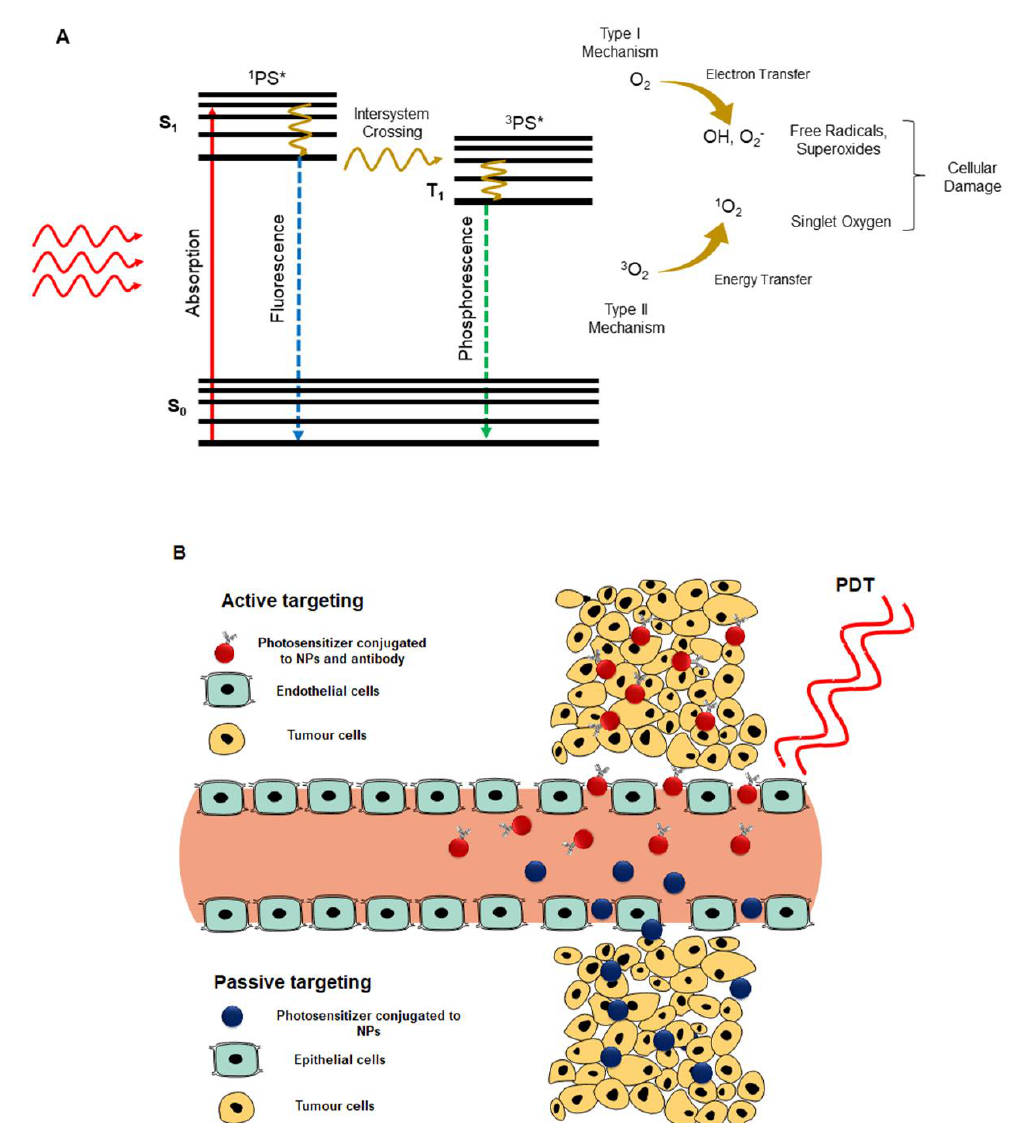
Figure 2. ( A ) PDT mechanism of action, as well as ( B ) passive and active tumor photosensitizer (PS) targeting approaches to generate reactive oxygen species (ROS) and singlet oxygen for tumor destruction (PS* indicates an excited state photo- sensitizer).